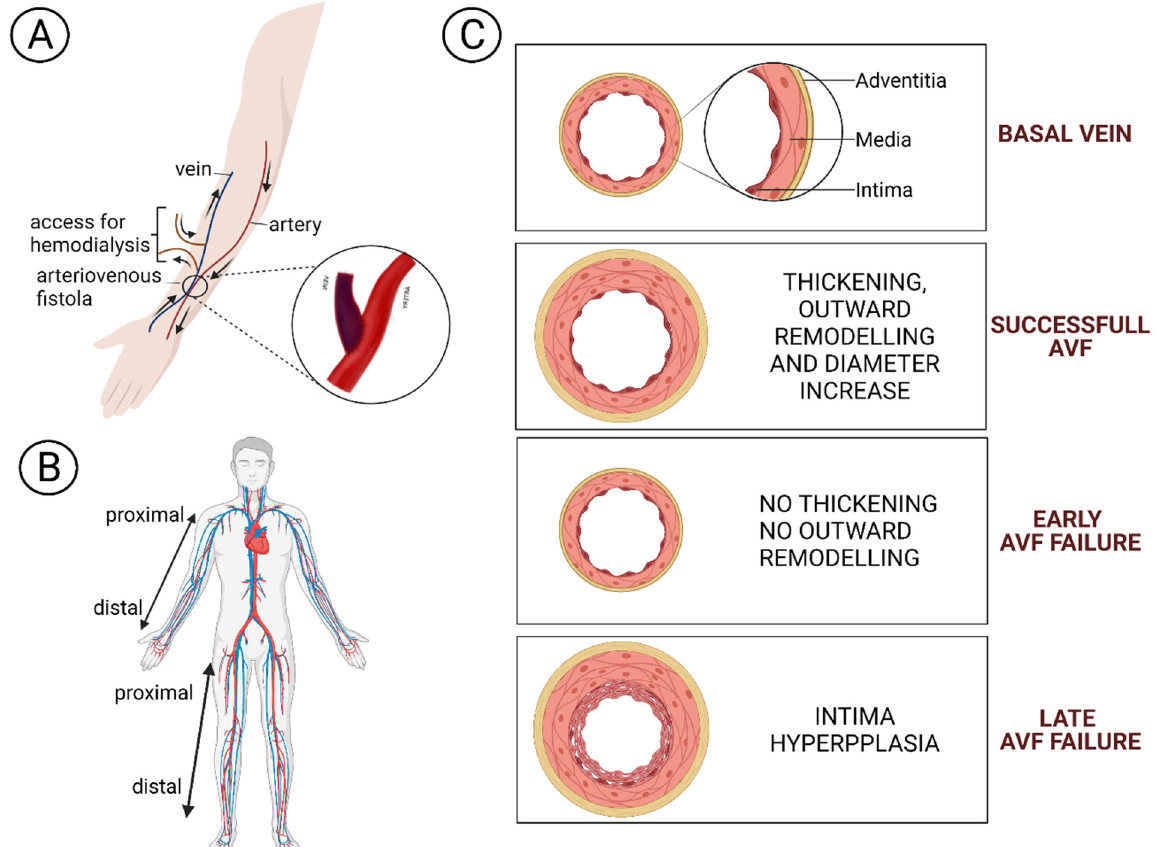
Figure 1. ( A ) An arteriovenous fistula is a connection between an artery and a vein in the arm to facilitate haemodialysis access. ( B ) AVF accesses preferences: first in the non-dominant upper limb, then in the dominant one, and as a final choice in the lower limb. ( C ) Vein wall remodelling in a successful AVF and during early or late failure.